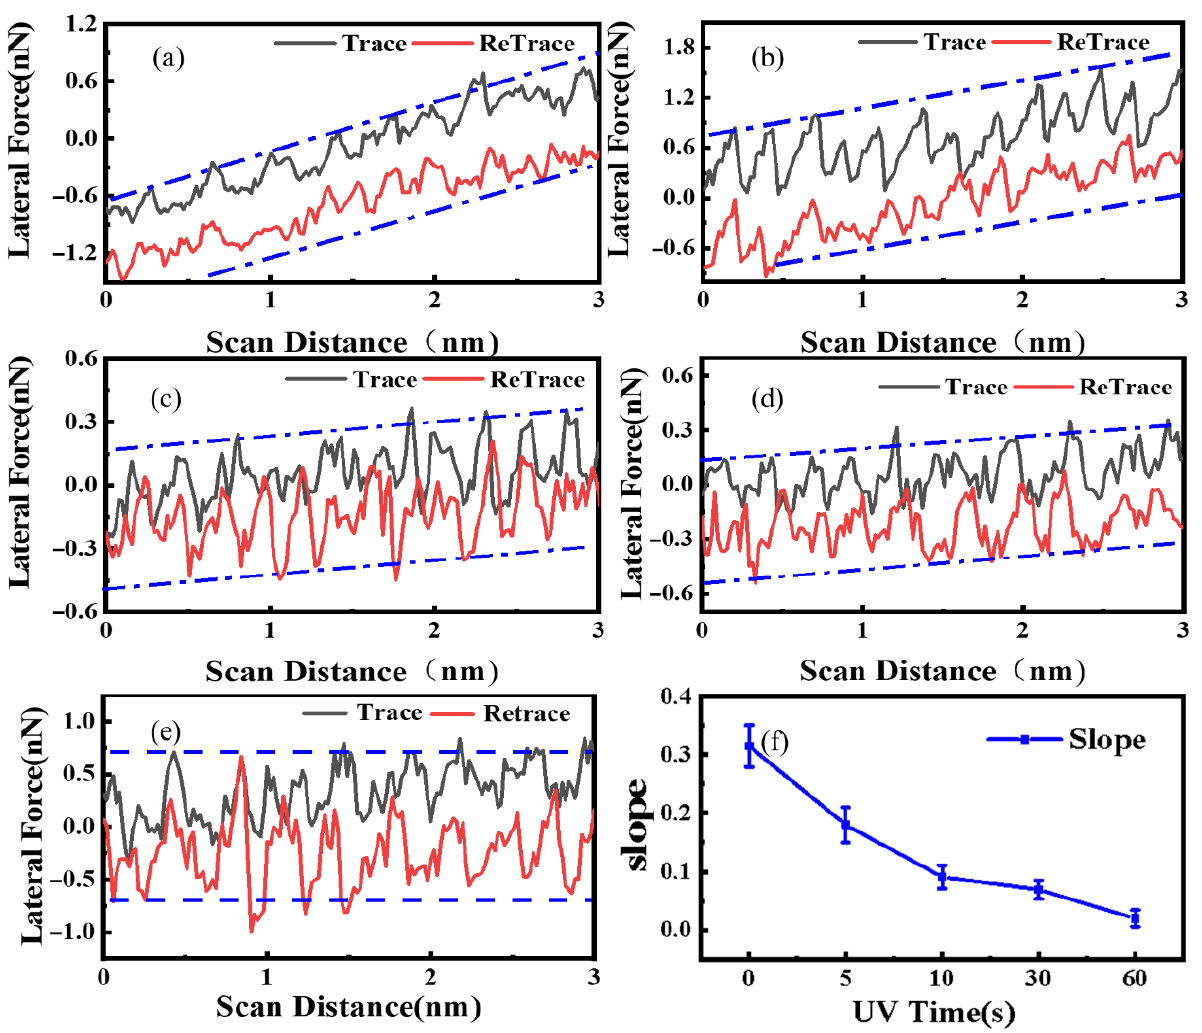
Figure 6. The friction force of graphene treated with UV vacuum at different times varies: ( a ) 0 s, ( b ) 5 s, ( c ) 10 s, ( d ) 30 s, ( e ) 60 s. ( f ) The values present the blue lines in ( a – e ) based on the least squares fitting